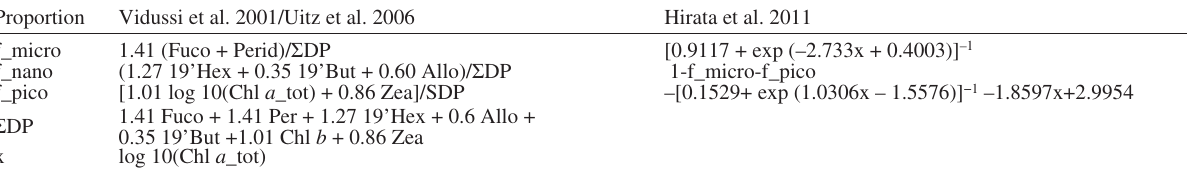
Table 2. – Expressions for the estimation of the proportion of phytoplankton in the microplanktonic, nanoplanktonic and picoplanktonic size classes (f_micro, f_nano and f_pico, respectively), based on diagnostic pigments [Vidussi et al. (2001) and Uitz et al. (2006)], and on the chlorophyll a _tot concentration (Hirata et al. 2011). S DP is the total chlorophyll a concentration recostructed from the concentrations of the considered diagnostic